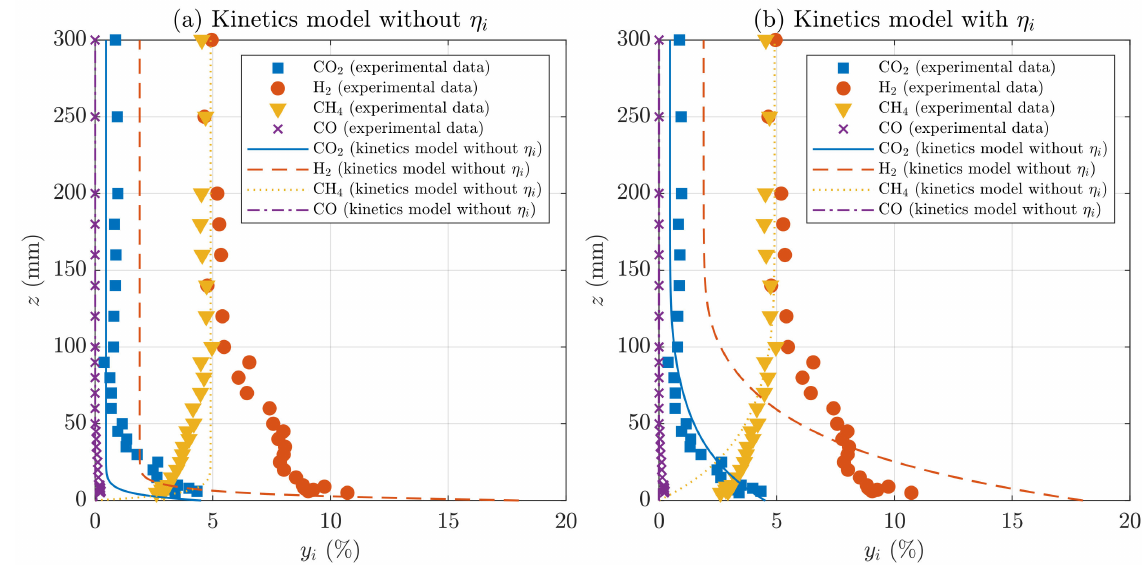
Figure 7. Comparison of axial mole fractions ( y i ) of CO 2 , H 2 , CH 4 , and CO between the experiment and kinetics model with ( a ) and without ( b ) the modification factors, η i .